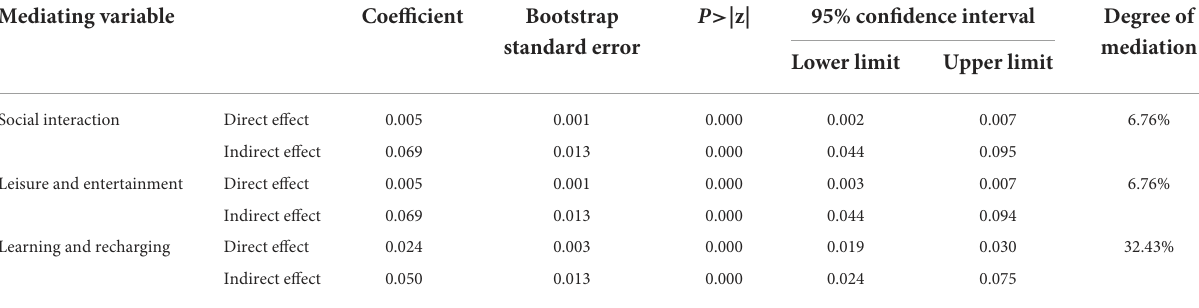
TABLE 6 Test of the mediating mechanism of internet use impacting sport participation